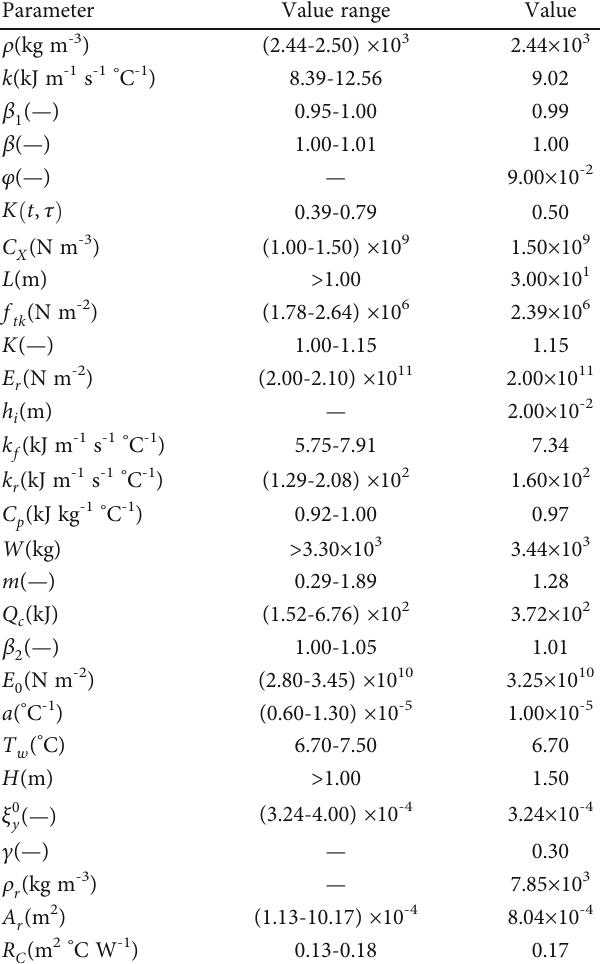
Table 3: Parameters were used in the solution of the theoretical